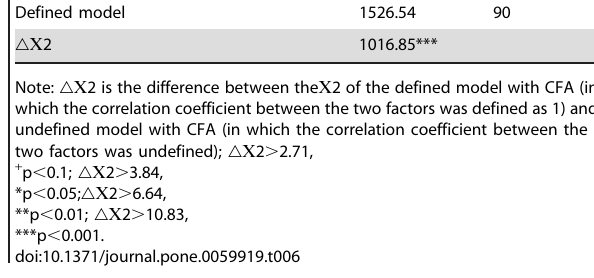
GIS-family planning